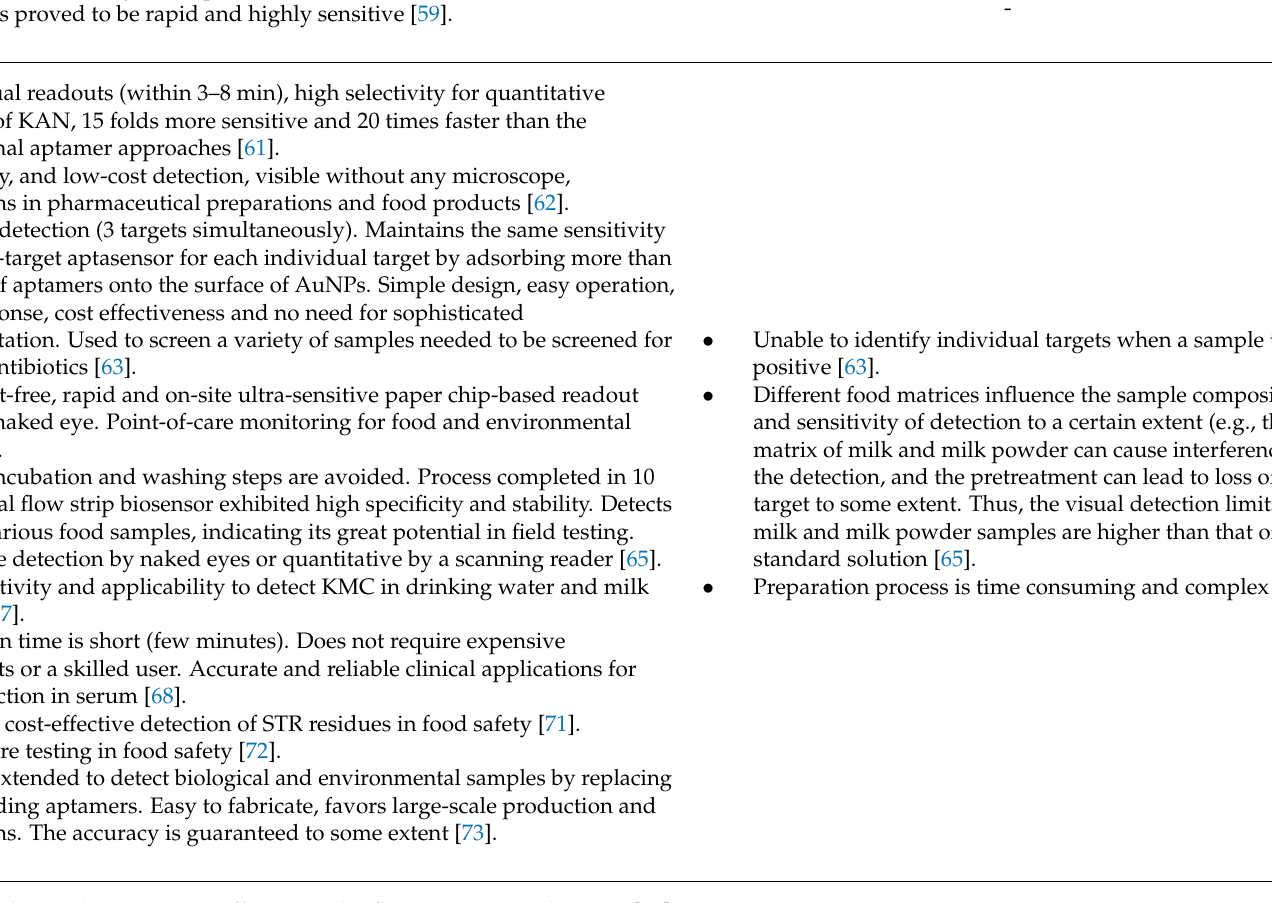
Table 3. Summary of advantages and disadvantages of the reported methods to make a comparison within each antibiotic class and with different classes. Antibiotic Group/Class Advantages Disadvantages • High detection accuracy dual aptasensor with fluorescence and colorimetric β -Lactams/(AMP) approaches proved to be rapid and highly sensitive